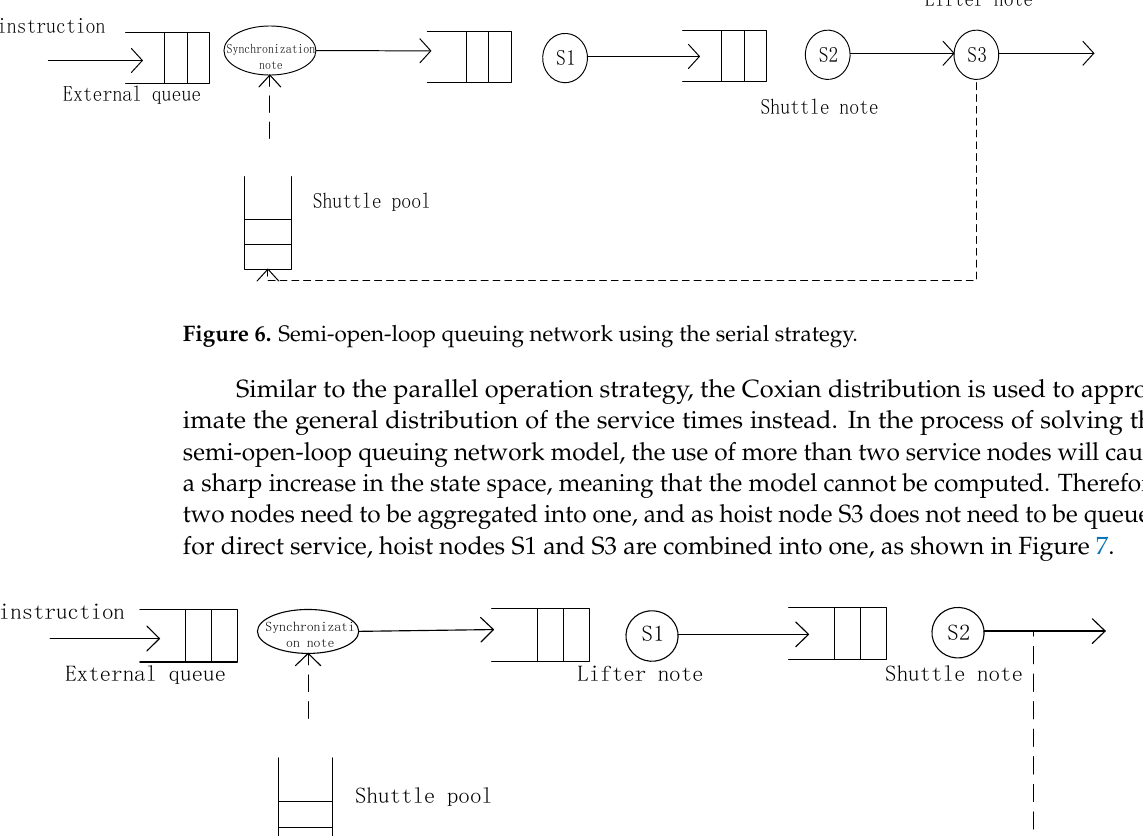
Figure 7. Integrated semi-open-loop queueing network .